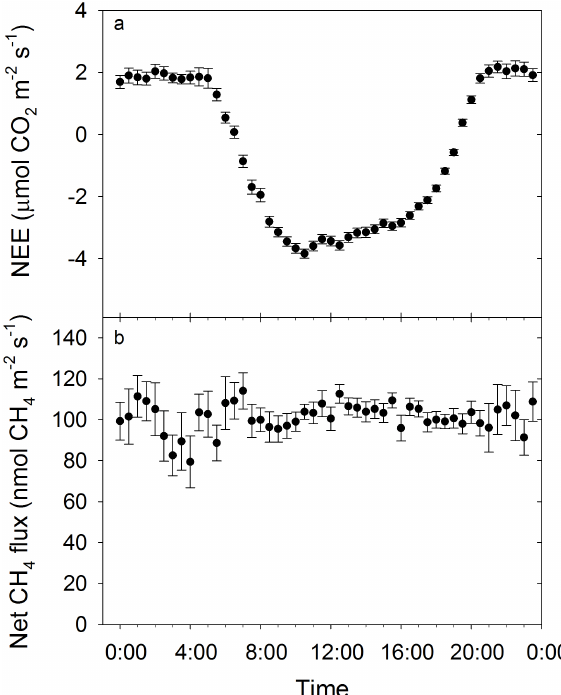
Fig. 2. Daily net ecosystem CO 2 exchange (NEE) (a) and net daily CH 4 (b) fluxes from a poor fen from 19 May to 27 September, 2011. The peatland is located in the Upper Peninsula of Michigan, USA. Positive values represent fluxes to the atmosphere and negative val- ues represent losses from the atmosphere.